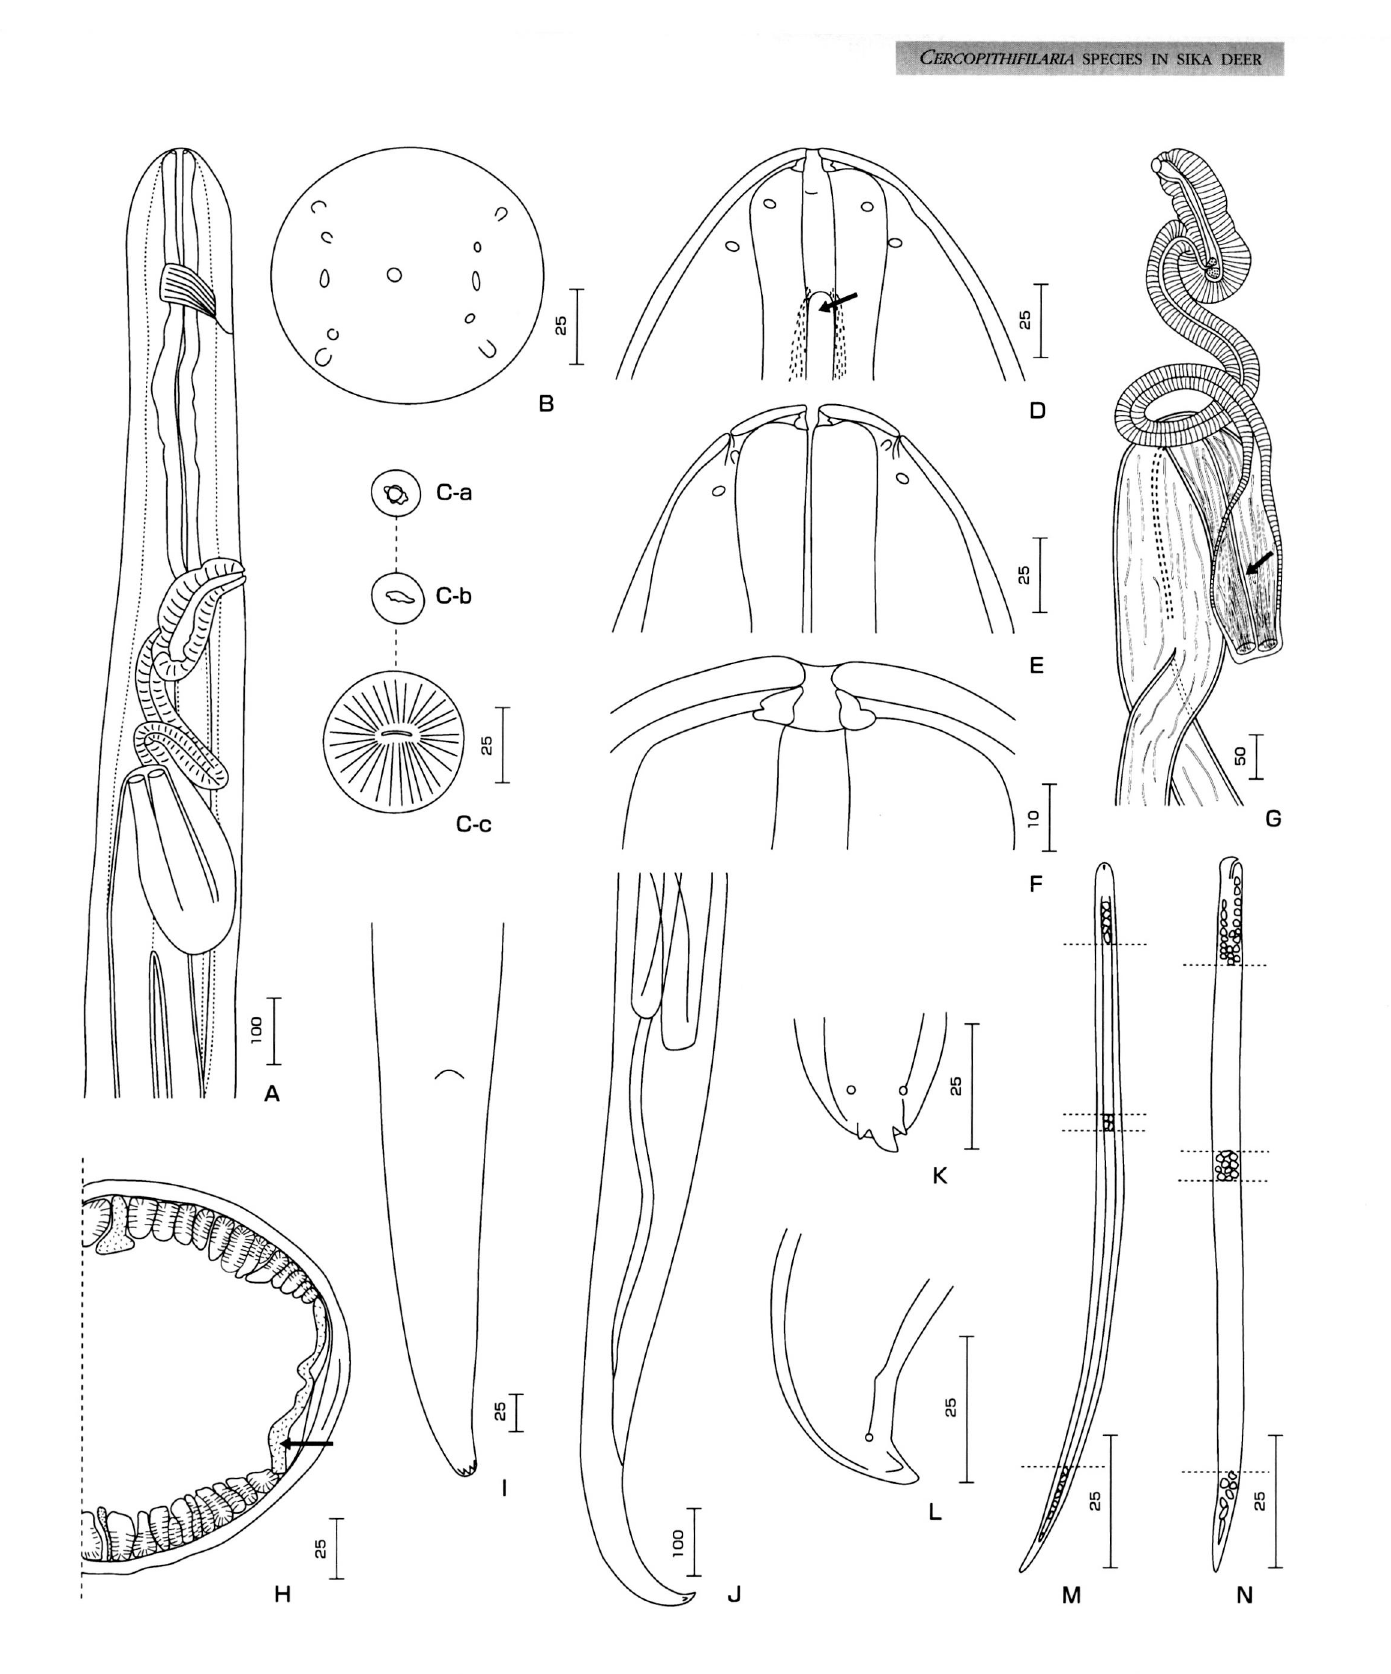
Fig. 3. - Cercopithifilaria crassa n. sp. A-L. females. A. Anterior part, lateral view. B. Anterior end, en face view. C-a. Mouth opening (small circle) and transverse section of the buccal capsule. C-b. Transverse section at base of buccal capsule. C-c. Transverse section at apex of esophagus. D. Head, with beginning of lateral chord (dots) and lateral cuticular thickening (arrow), lateral view. E. Head, median view. F. Buccal capsule, median view. G. Vagina, ovejector and division of uteri (arrow indicates the joined part). H. Transverse section of the midbody (arrow, lateral chord) I. Tail, ventral view. J. Posterior part, lateral view. K. Caudal extremity, ventral view. L. Caudal extremity, lateral view. M-N. Microfilariae. M. Entire body, left lateral view. N. Entire body, median view. Bars, micrometers. Parasite. 2002. 9.